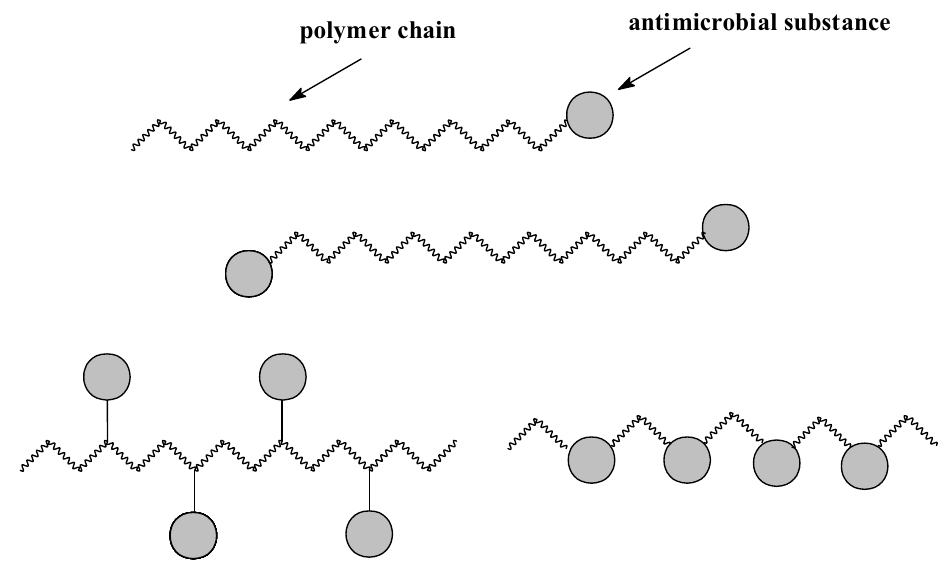
Figure 2. Structure of macromolecular conjugates of active